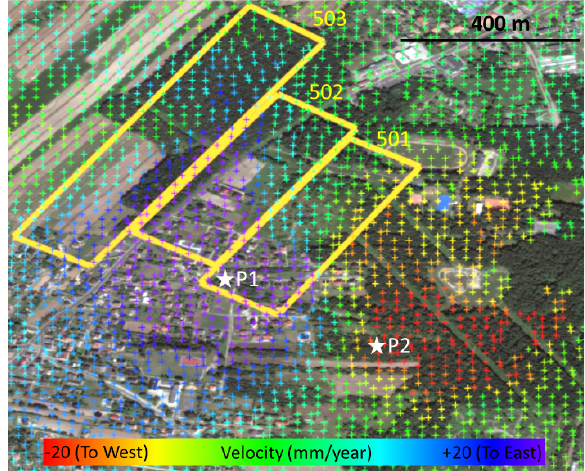
Figure 15. Mean east-west velocity map (January – October, 2021) subject to underground mining in Lędziny , Poland (Figure 10). Three mining regions: 501, 502, and 503. P1 and P2 for point-based analysis in Figure 16.